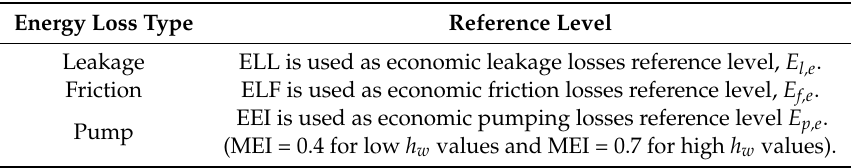
Table 1. Reference levels for operational